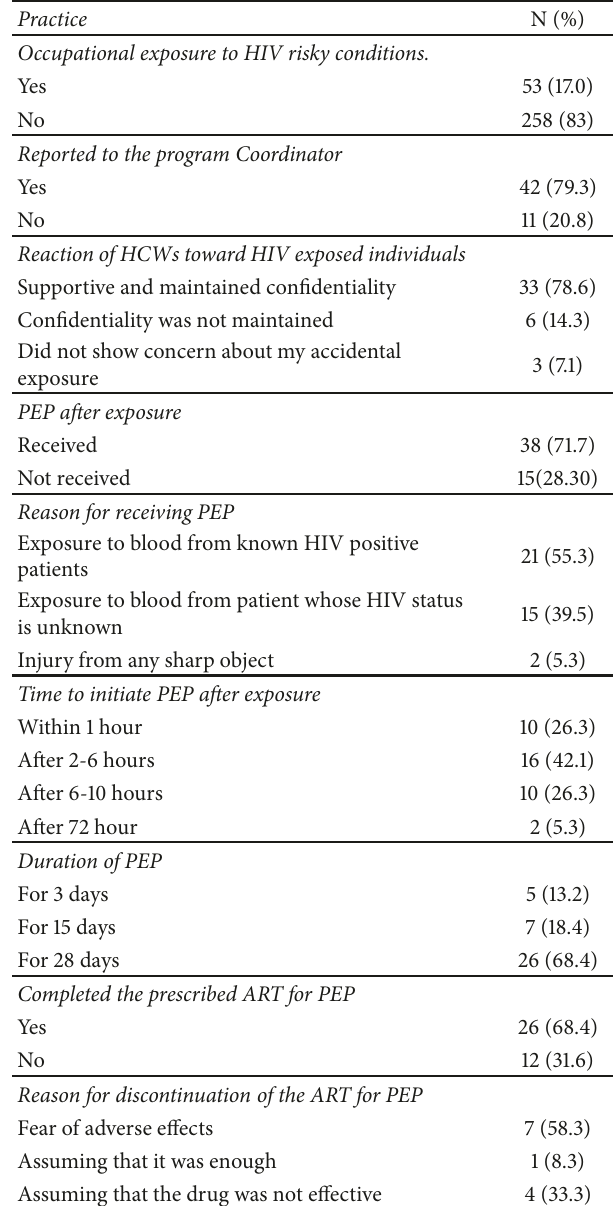
Table 4: Practice of PEP for HIV among HCW in Hiwot Fana Specialized University Hospital,